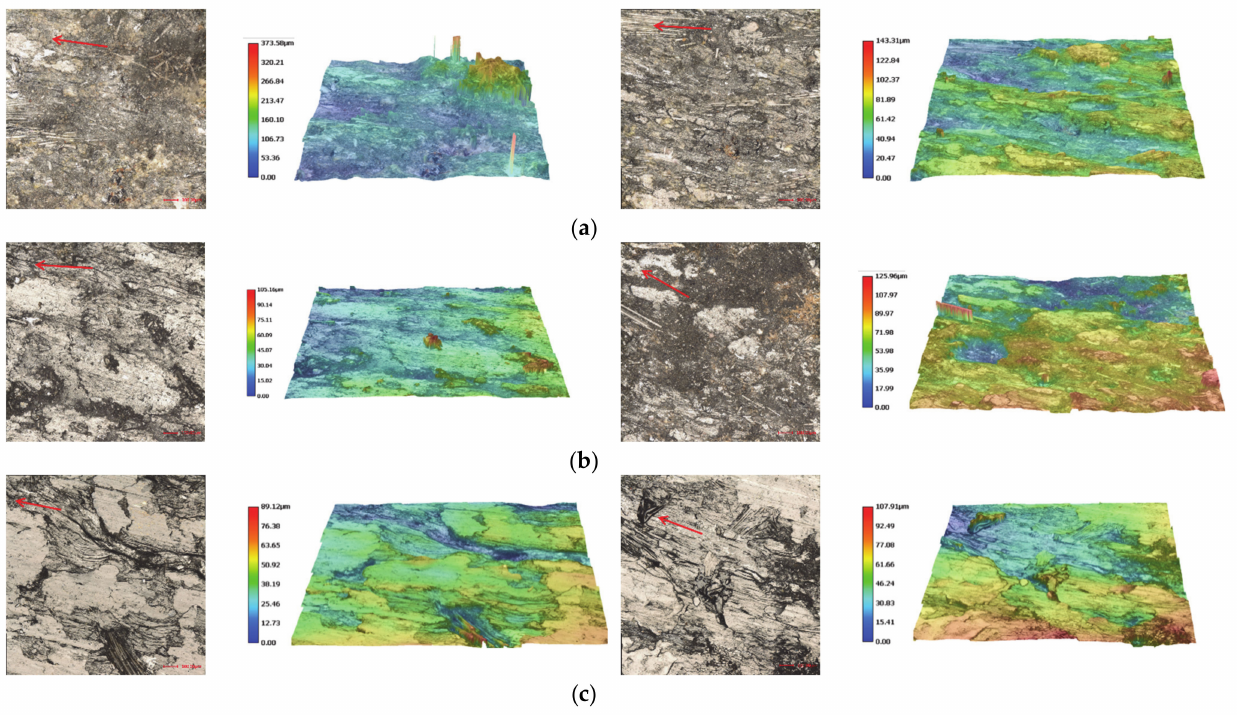
Figure 20. Microscopic morphologies and three-dimensional profiles of brake shoe specimens at both sides of the brake disc in cases of different emergency braking times (the red arrow represents the sliding direction of the brake disc). ( a ) t = 30 s; ( b ) t = 60 s; ( c ) t = 120 s.